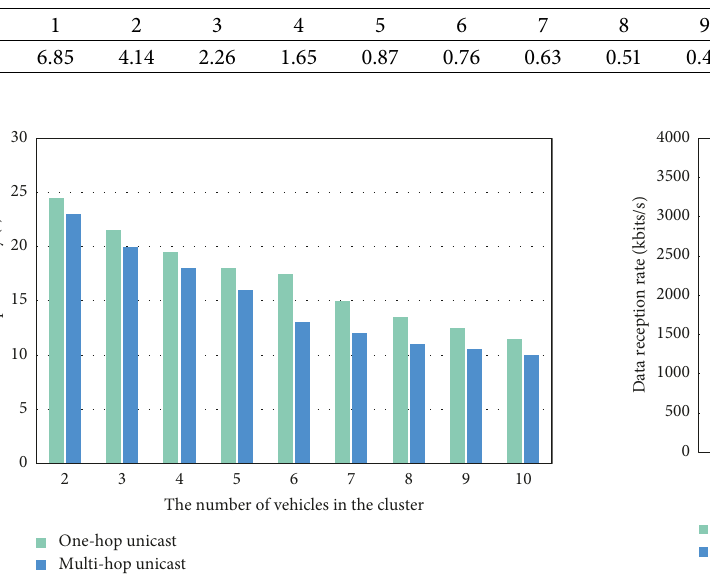
Figure 6: Relationship between data reception rate and the number of vehicles in a cluster based on multihop multicast and one-hop multicast algorithms.